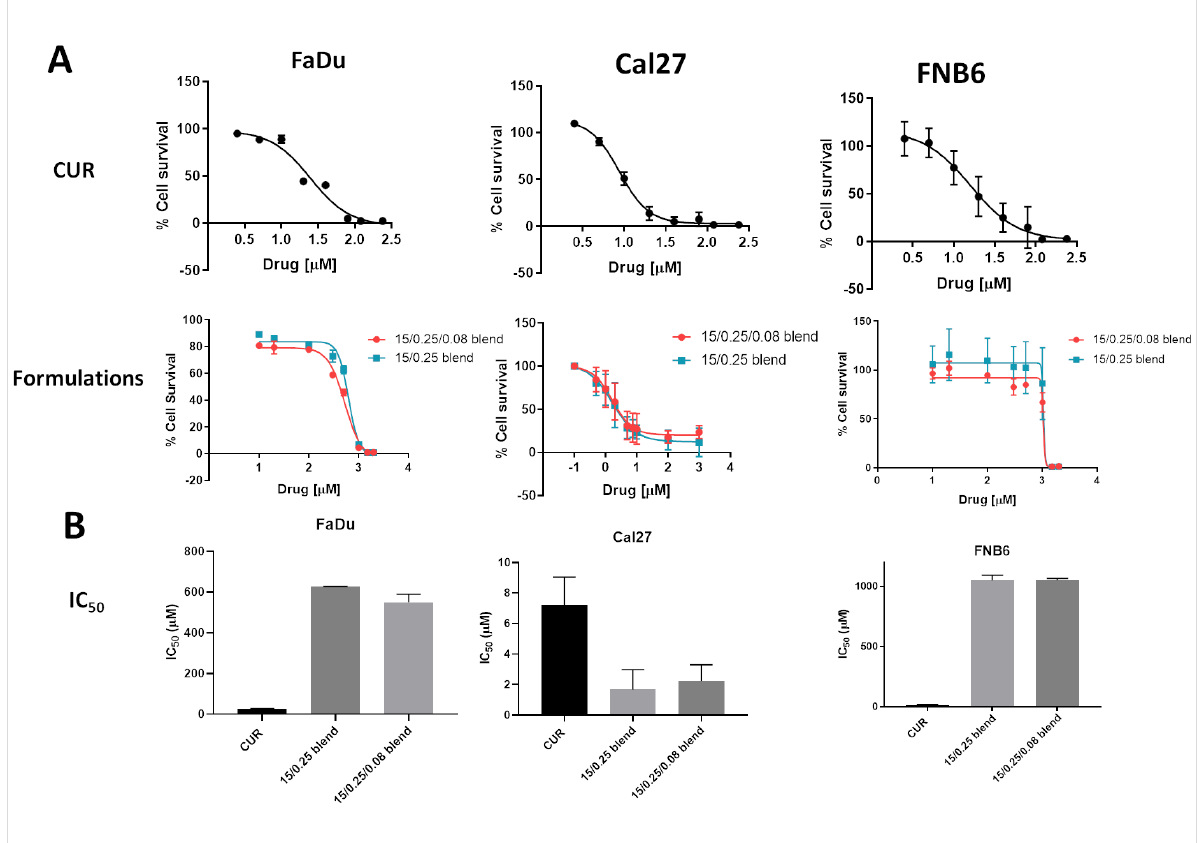
Figure 12: Cytotoxicity of formulations: (A) cell survival curves of drug and formulations, (B) IC 50 comparisons of drug and formulations for two SCC (FaDu and Cal27) and one normal oral (FNB6) cell lines. Each IC 50 value and percent cell survival represent average ± SEM ( n = 3). CUR dispersed in DMSO aqueous solution exhibited cytotoxicity on all three cell types with average IC 50 of 24.90 ± 2.30, 7.205 ± 1.831, 15.916 ± 3.440 µM, for FaDu, Cal27 and FNB6, respectively. The possible DMSO interference on methodology was investigated (Supporting Information File 1, Figure S2).